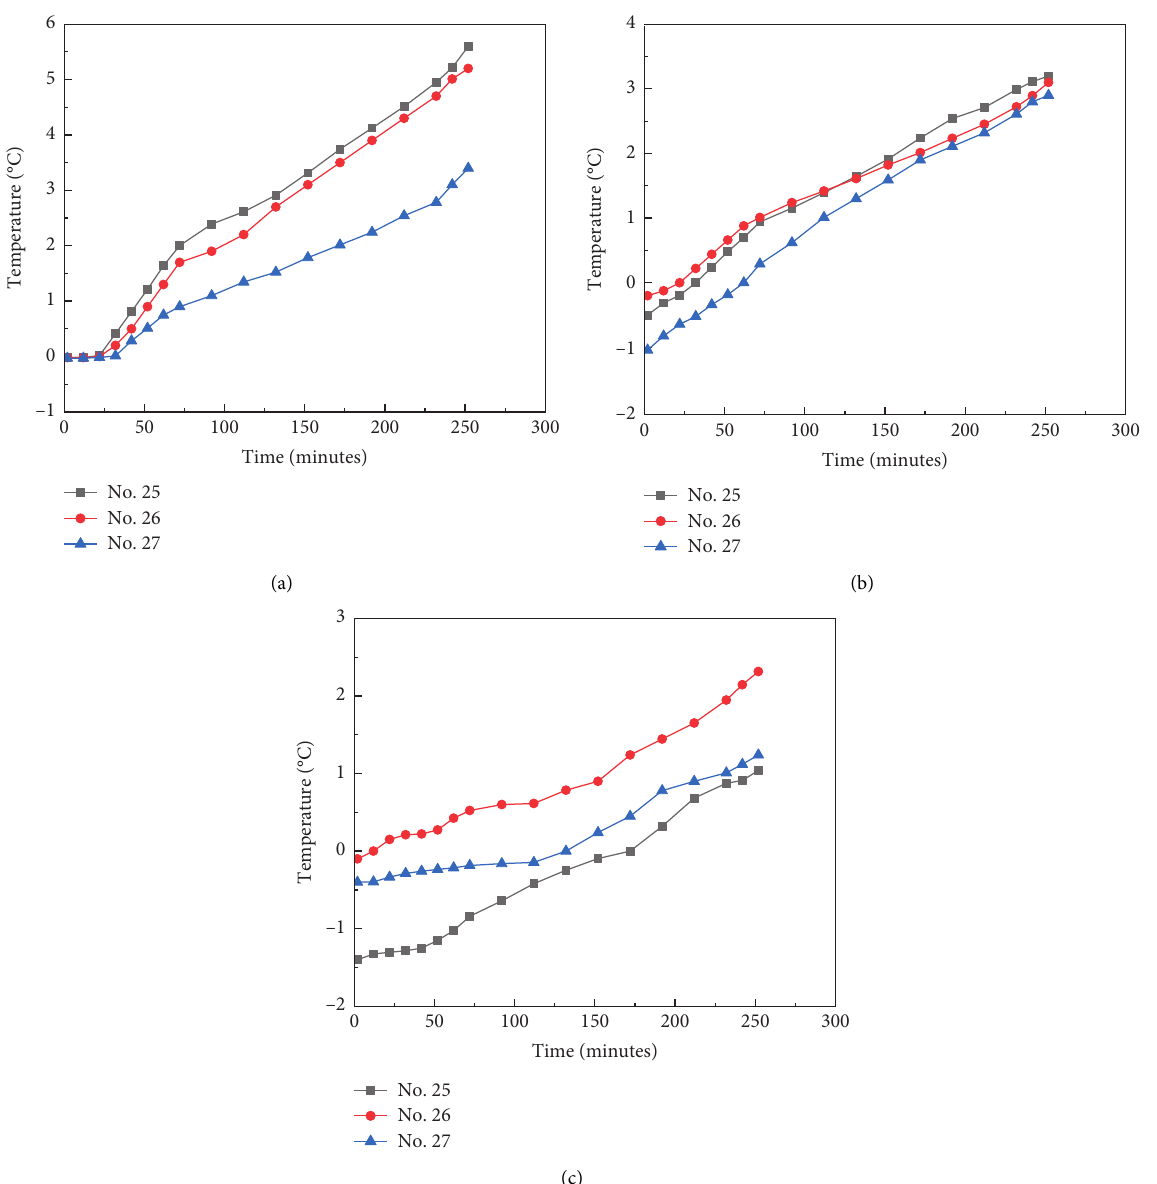
Figure 14: Temperature change curves of measuring points Nos. 25, 26, and 27 under various working conditions of ice melting experiment: (a) − 2 ° C; (b) − 4 ° C; (c) − 8 ° Table 9: Temperature change rate of the first layer’s measurement points Nos. 25, 26, and 27 of the ice melting experiment. Environmental conditions